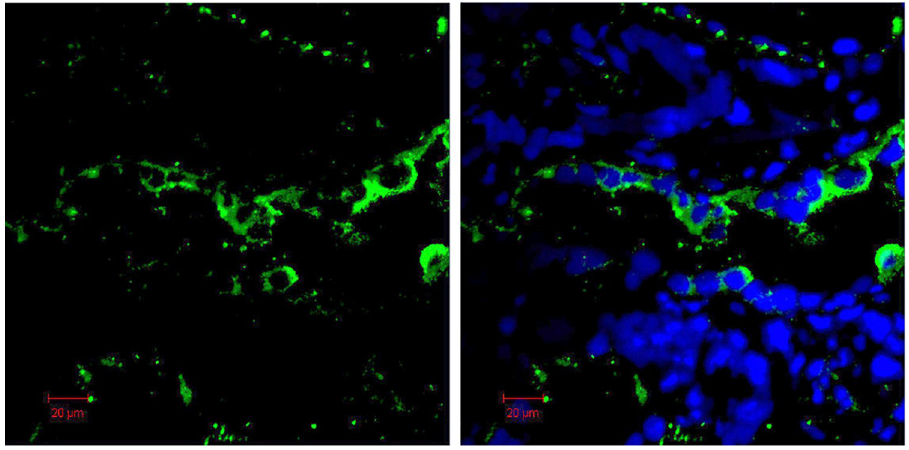
Fig 7. Immunofluorescence staining of cryosections of a kidney removed because of a renal cell carcinoma using rabbit anti human C3-specific antibody. Tubular epithelial cells contain intracellular C3 (left panel). Merging C3 staining with DAPI nuclear staining (right